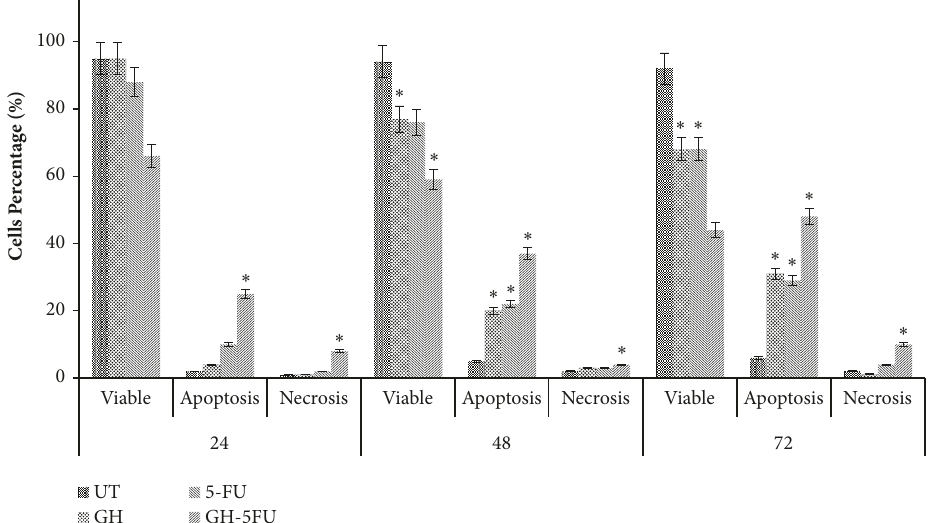
Figure 4: Mode of cell death of untreated HT-29 cells and those which have been treated with GH, 5-FU, and both. Error bars represent means ± S.E.M. of the three independent experiments. ∗ Statistical significance (p < 0.05) between control cells and treatment groups.